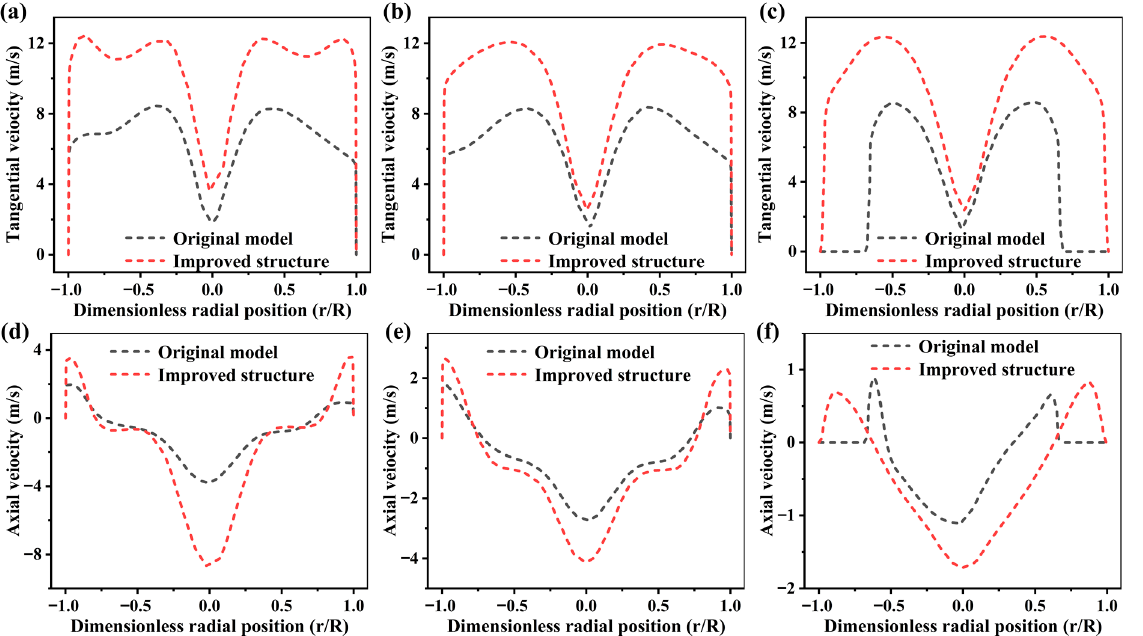
Figure 13. The tangential velocity and axial velocity distribution of the original structure and the improved structure. From top to bottom: tangential velocity and axial velocity. From left to right: P 0 , P 1 , and P 2 .